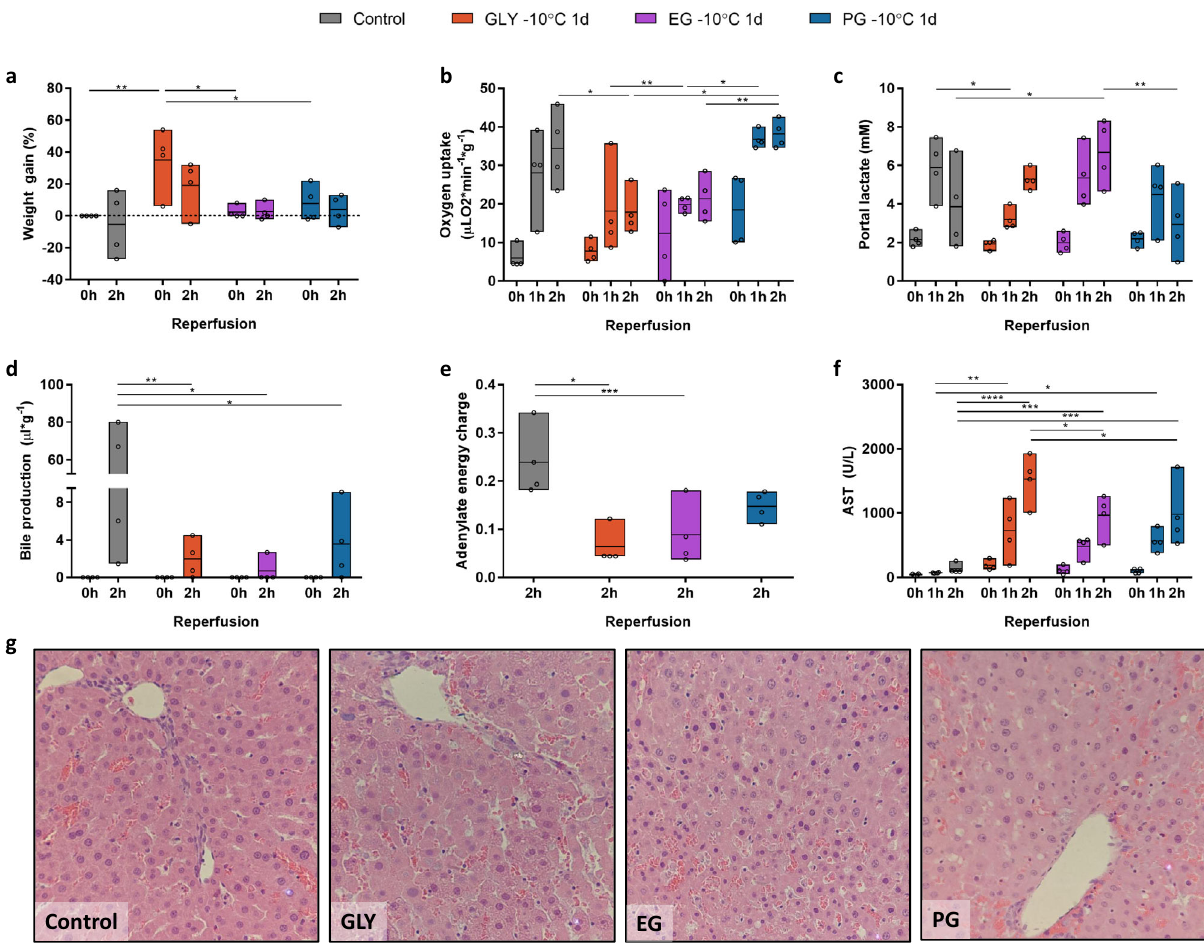
Fig. 2 Effect of permeating cryoprotective agents on liver function, injury, and microscopic tissue structure after partial freezing at − 10 °C for 24 h. a Weight gain as percentage of the procurement weight. b Oxygen uptake. c Lactate concentration in the portal vein. d Bile production. e Tissue adenylate energy charge. f Aspartate aminotransferase concentration (AST) in the intrahepatic vena cava (IVC). g Light microscopy images of parenchymal liver wedges at the end of simulated transplantation (×40). Controls (gray) = 1 day hypothermic preservation, GLY glycerol (red), EG ethylene glycol (purple), PG propylene glycol (dark blue). Stars denote statistical signi fi cance (two-way ANOVA, followed by Tukey ’ s post-hoc test): *0.01 < p < 0.05; **0.001 < p < 0.01; ***0.0001 < p < 0.001; **** p < 0.0001. Boxes: fl oating bars (min to max), with a line at the mean. Source data are provided as a Source Data fi